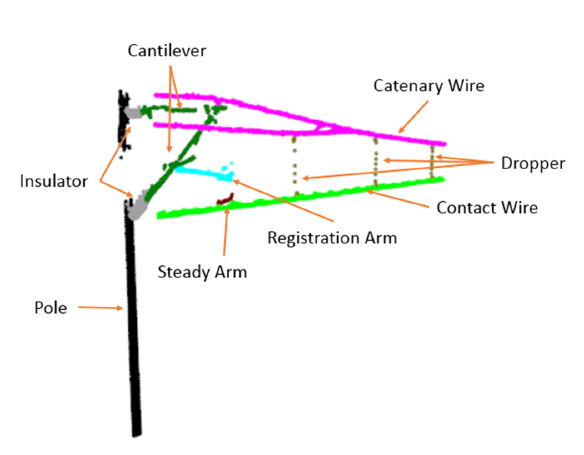
Figure 3. Annotated point cloud of